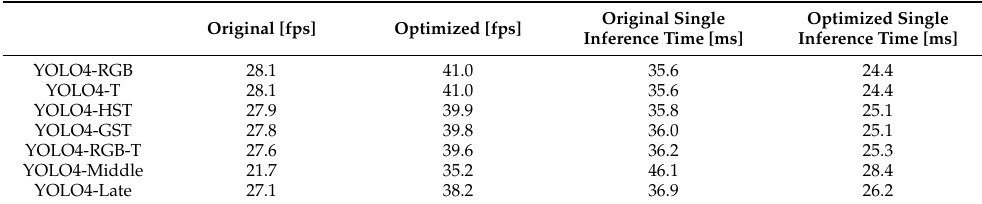
Table 3. Model inference expressed in fps for all of the YOLOv4